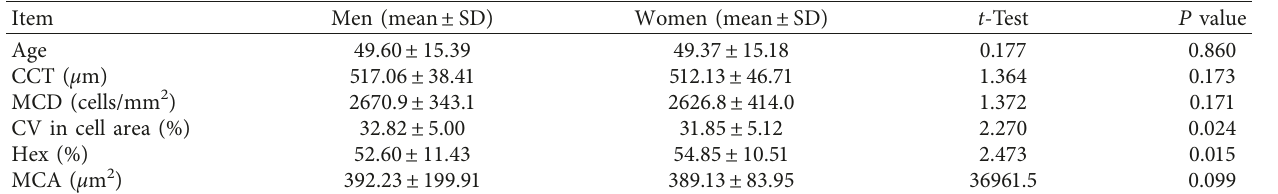
Table 2: Comparison of age and variables pertaining to the corneal endothelial cell density and morphology between men and women in our cohort of Egyptian subjects with healthy